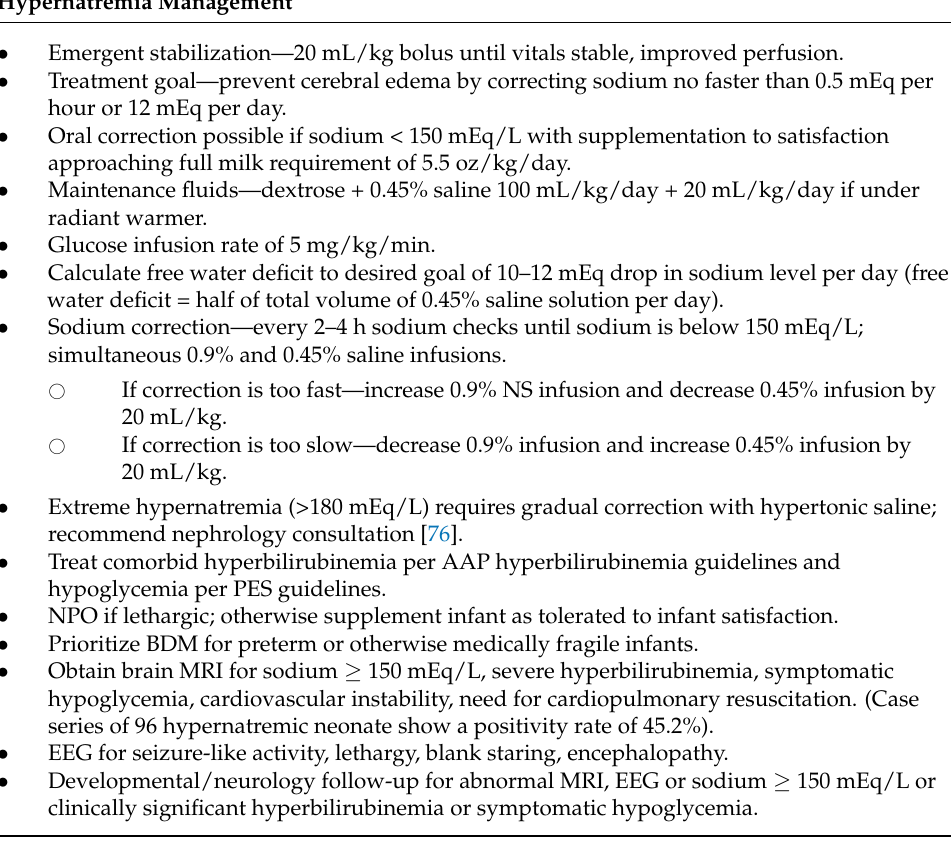
Table 5. Acute management of hypernatremia. Adapted with permission from Durrani et al.